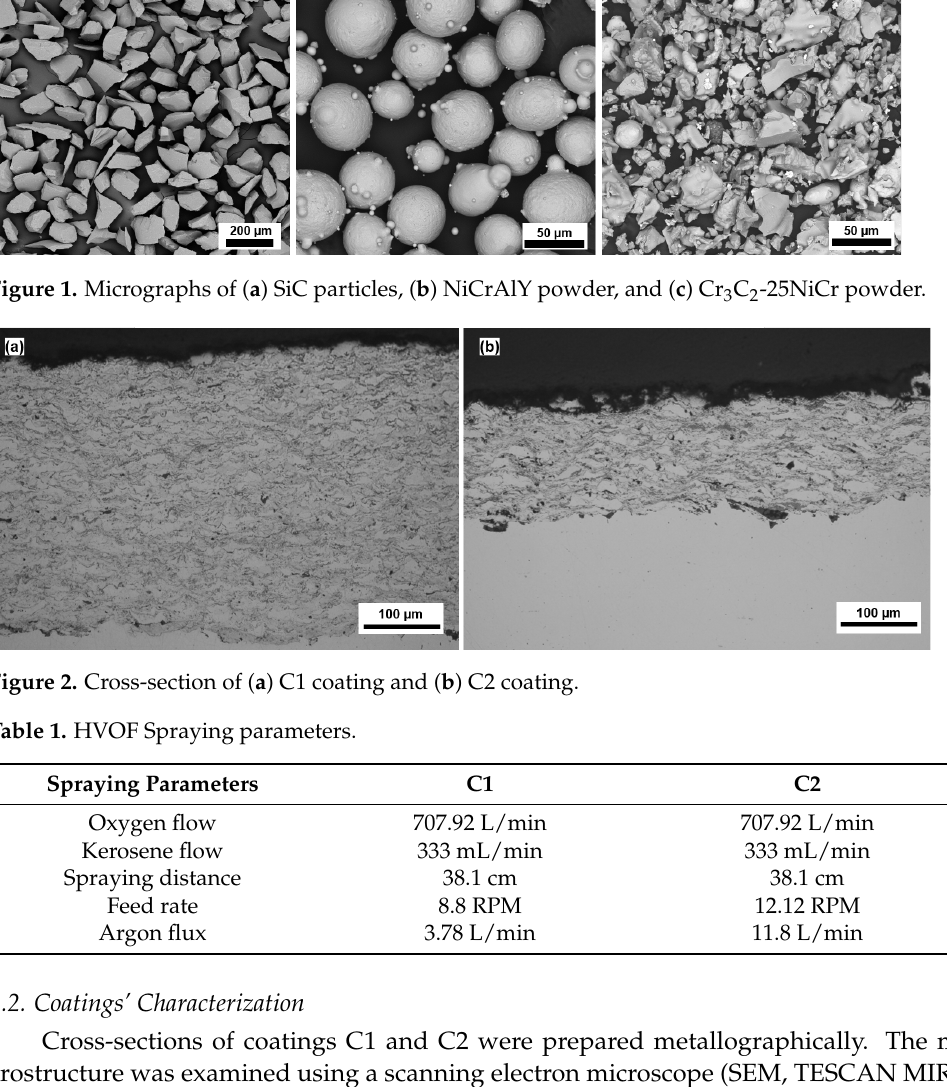
Figure 2. Cross-section of ( a ) C1 coating and ( b ) C2 coating. Table 1. HVOF Spraying parameters.